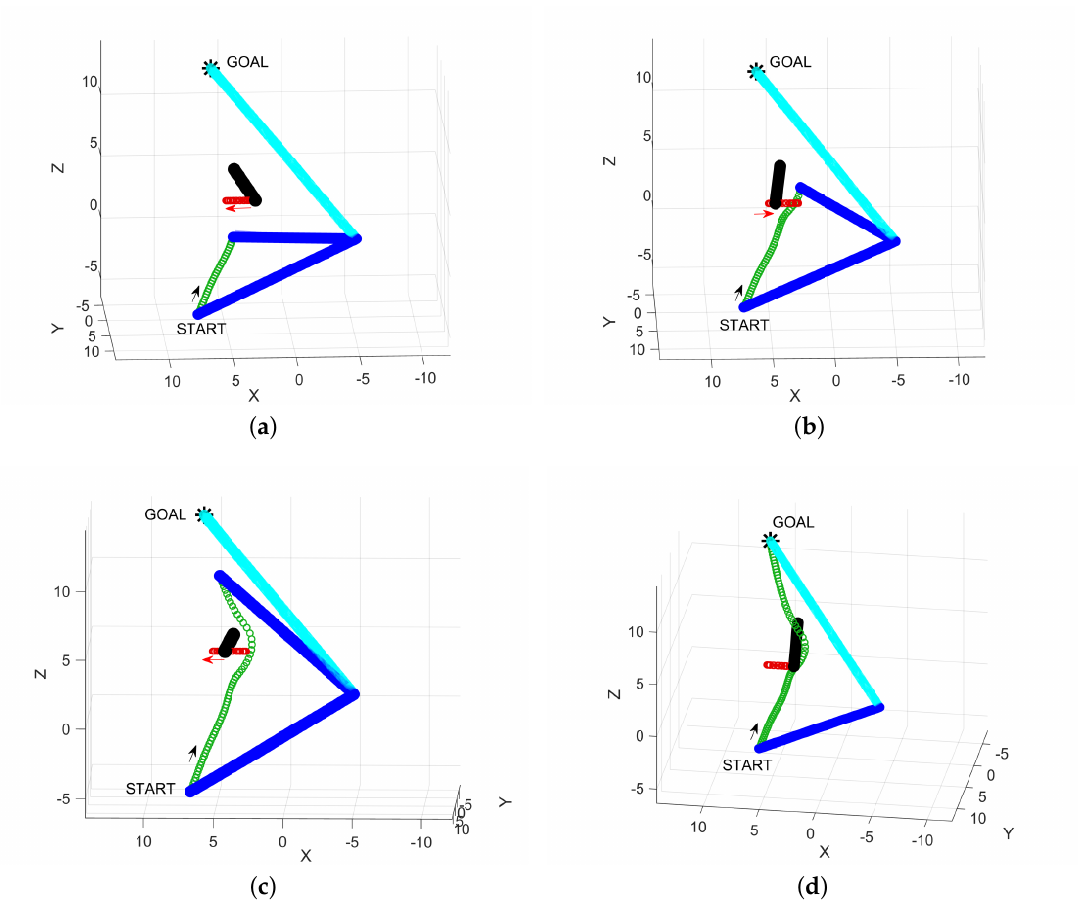
Figure 6. In blue, the starting position and the position in the snapshot of the robot, while in light-blue, the goal pose. In black, the obstacle. In red, the trajectory of the obstacle tip. In green, the real trajectory of the EE. The black arrows show the direction of the movement of the obstacle tip in that snapshot. ( a ) First snapshot; ( b ) second snapshot; ( c ) third snapshot; ( d ) final